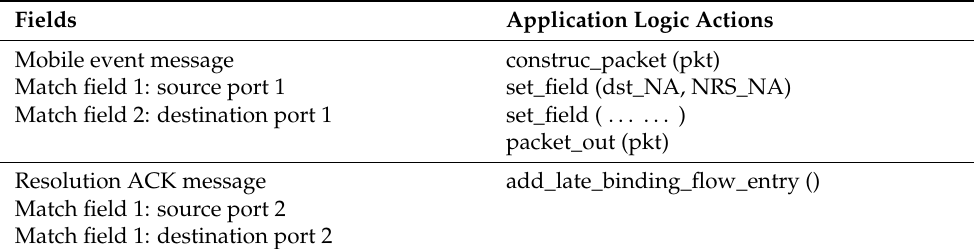
Table 3. Mobile signaling processing rule table.